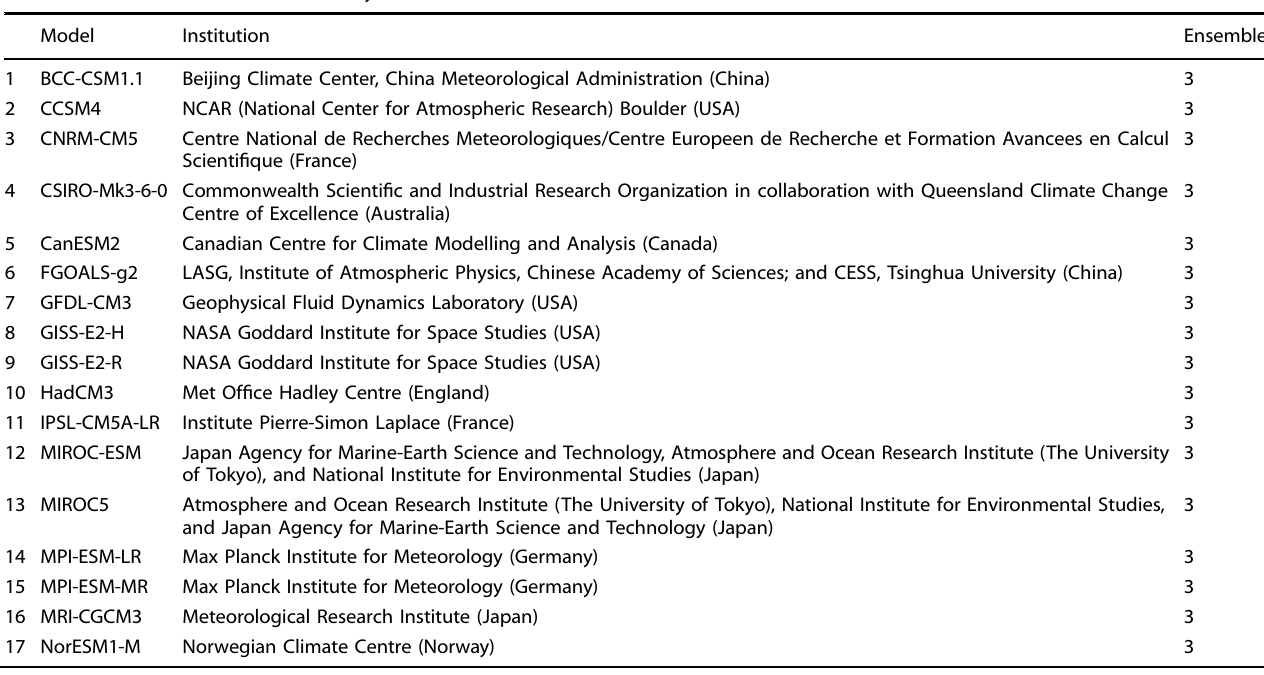
Table 1. CMIP5 models used in this